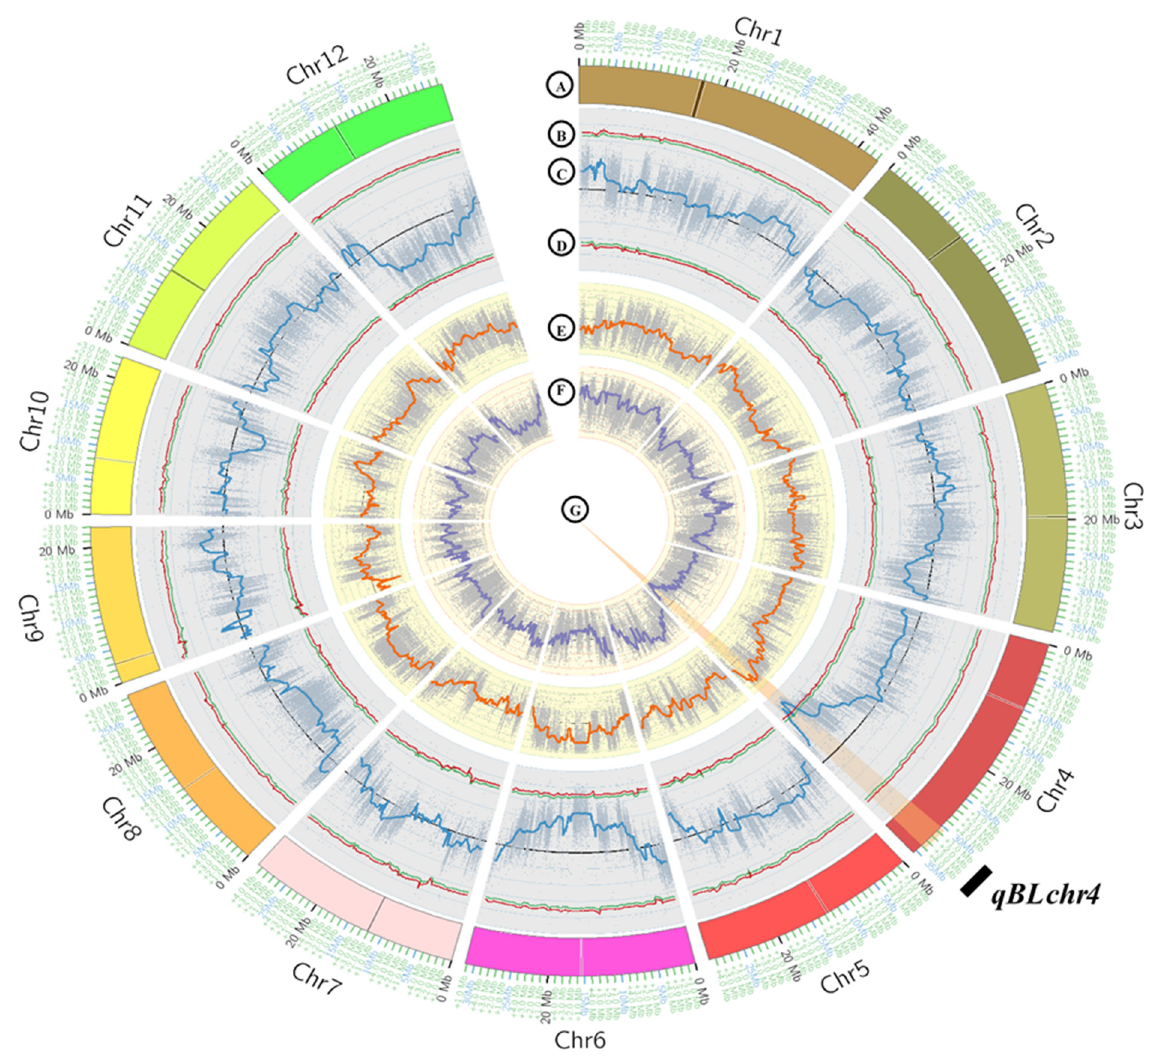
Figure 3. SNP index plots of BLR-bulk and BLS-bulk and plots of ∆ (SNP index) obtained by subtract- ing between them: (A) pseudomolecules of Nipponbare reference genome (IRGSP 1.0); (B) upper probability values at 95% ( p < 0.05; green line) and 99% confidence ( p < 0.01; red lines); (C) plots of ∆ (SNP index) with a window size of 2 Mb and 10 kb increment; (D) lower probability values at 99% ( p < 0.01; red lines) and 95% confidence ( p < 0.05; green line); (E) SNP index plots of BLR-bulk with a window size of 2 Mb and 10 kb increment; (F) SNP index plots of BLS bulk with a window size of 2 Mb and 10 kb increment; and (G) candidate genomic regions encompassing qBLchr4 for blast resistance.